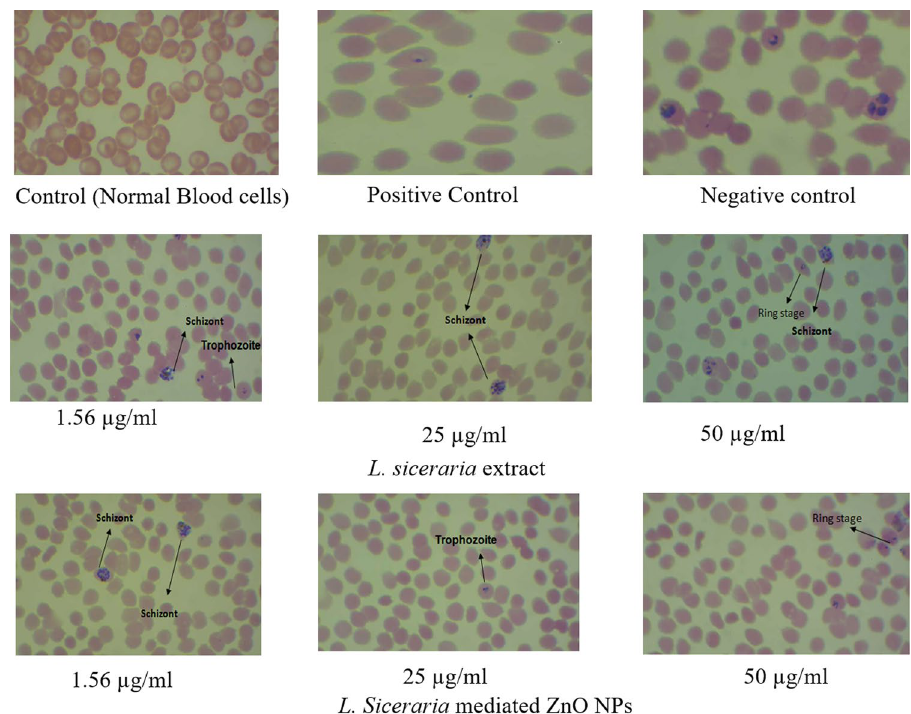
Figure 5. Validation of SYBR Green results by microscopy.